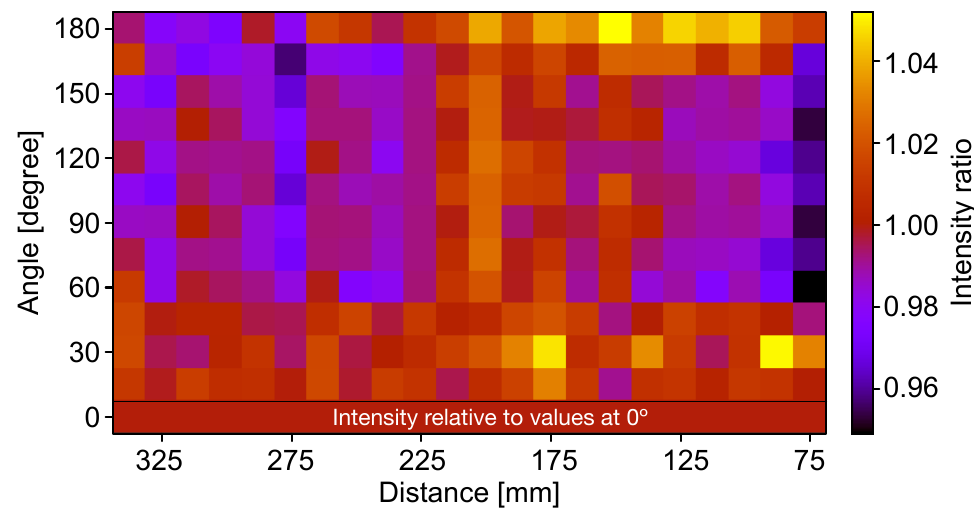
Figure 10. A 2D scan of the relative efficiency of a quartz tube. For a given longitudinal position, the efficiency is relative to the corresponding value at 0 ◦ in order to correct for the longitudinal intensity dependence. The angular variation of the efficiency is less than ±